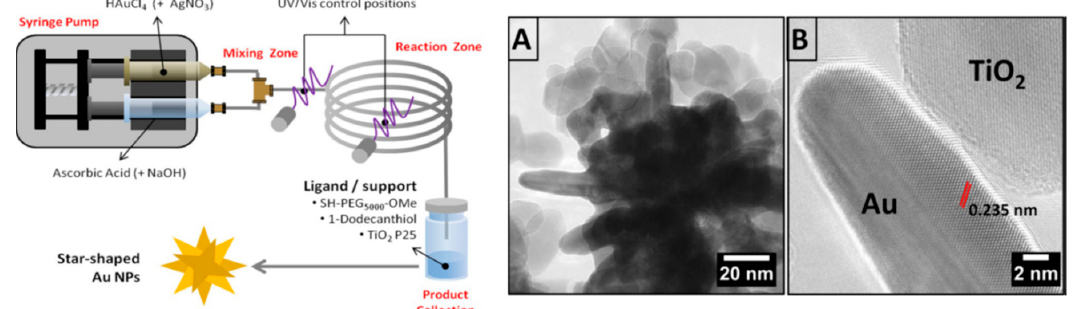
Figure 7. Left: Scheme of the fluidic production of multibranched AuNUs. The precursors loaded in the syringes can be mixed in the T-mizer (mixing zone), in the reactor (1 m) the AuNUs form and drop directly in an excess of ligand for proper stabilization. Right: ( A ) TEM image of a single multibranched gold nanoparticle immobilized on titania; ( B ) HR-TEM image of a single branch interacting with a titania. Reproduced from [56] with permission from John Wiley and Sons.